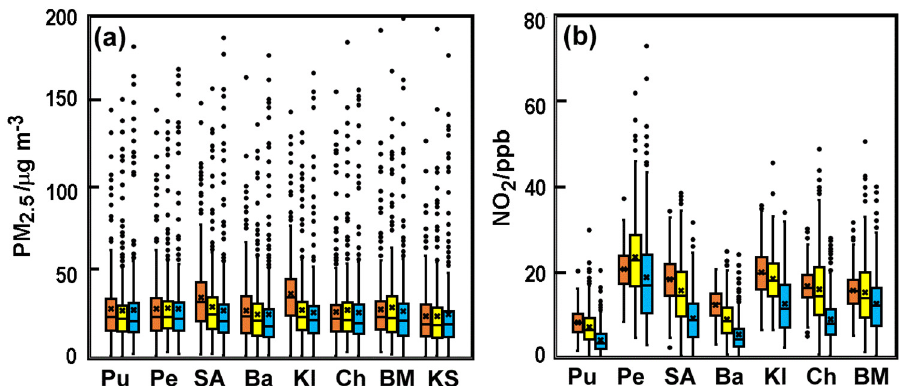
Figure 4. The concentrations of ( a ) PM 2.5 and ( b ) NO 2 at the sites for the hourly averages ending at 08:00 (orange), 11:00 (yellow), and 14:00 (blue). Note: The sites are coded Putrajaya (Pu), Petaling Jaya (Pe), Shah Alam (SA), Banting (Ba), Klang (Kl), Cheras (Ch), Batu Muda (BM), and Kuala Selangor (KS); the last for PM 2.5 only. The boxes define Q 1 and Q 3 , the line denotes the median, the X is the mean, and the whiskers run to the points that lie within 1.5 times the interquartile range above and below Q 1 and Q 3 . Table 1. Pollutant concentrations (from hourly averages from 2019 data) adopted for various activities related to school at sites around Kuala